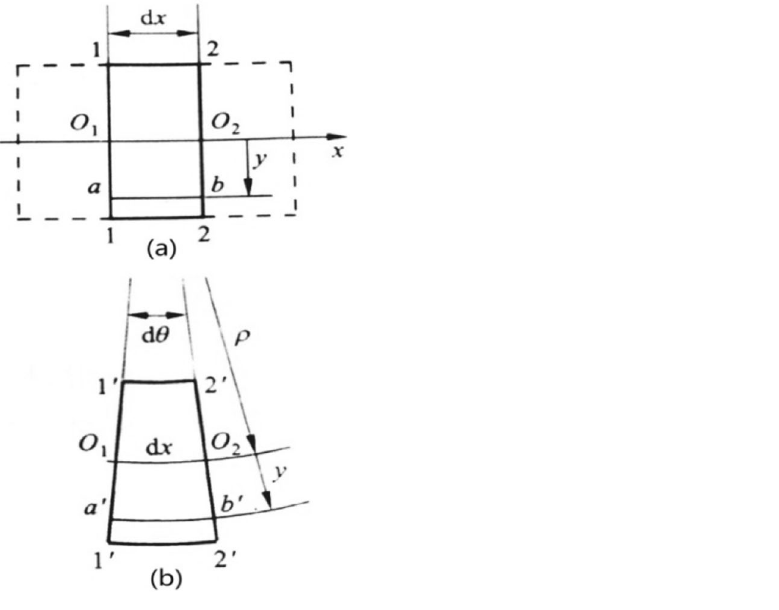
Figure 2. Diagram of pure bending geometric deformation of micro element